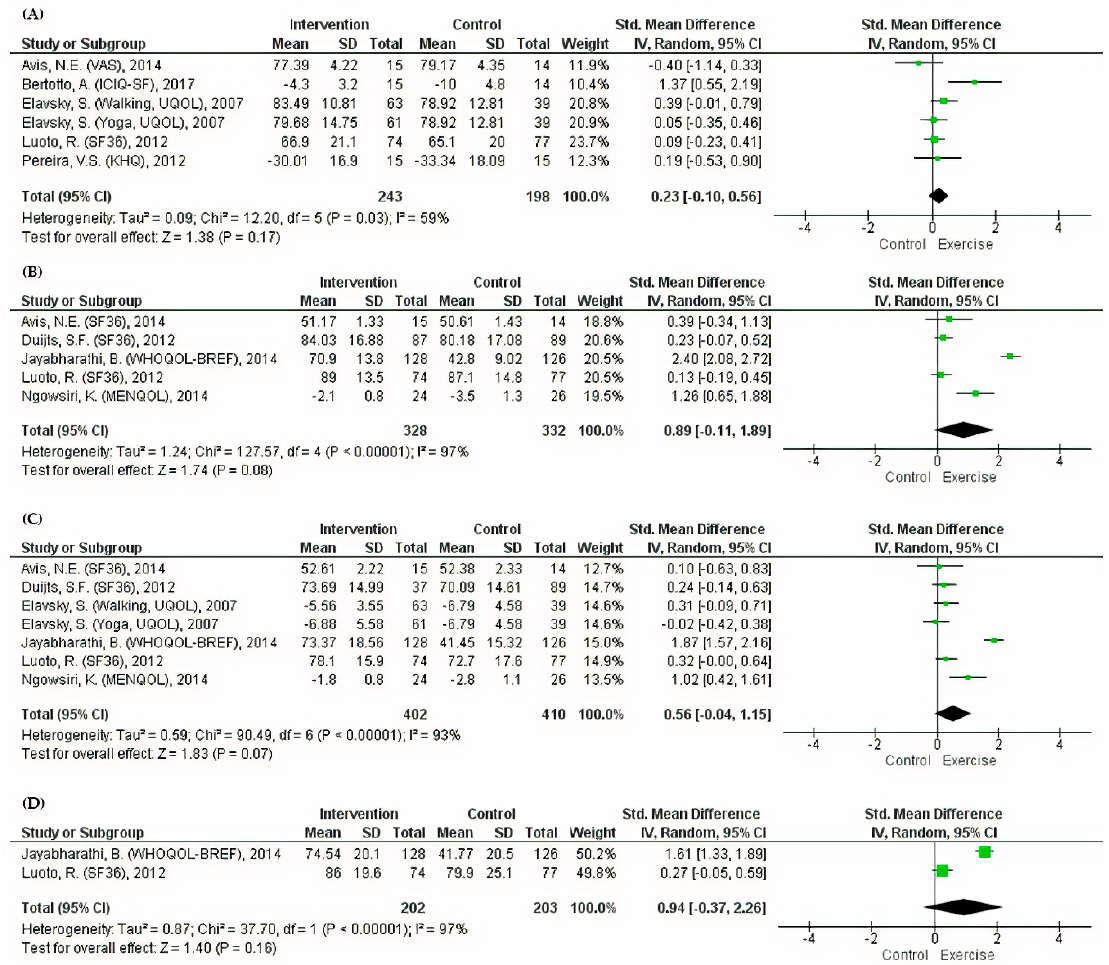
Figure 2. Meta-analyses of the e ff ects of exercise on general QoL domains. ( A ) Forest plot of six datasets on general QoL. ( B ) Forest plot of five datasets on the physical component of QoL. ( C ) Forest plot of seven datasets on the psychological component of QoL. ( D ) Forest plot of two datasets on the social component of QoL.